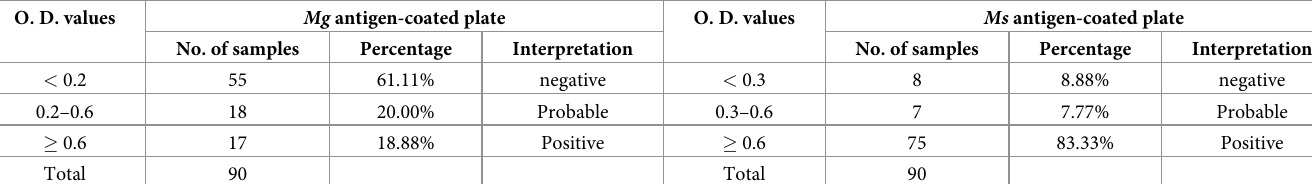
Table 3. Results of indirect ELISA for diagnosis of Mg and Ms infection in different chicken breeds. O. D. values